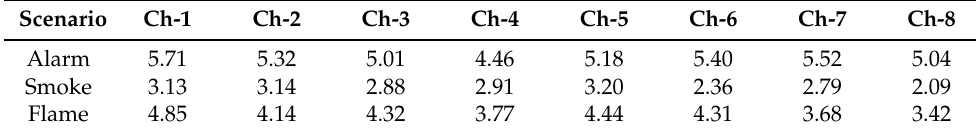
Figure 16. Activation coefficient. Table 14. Mean values of activation coefficient.